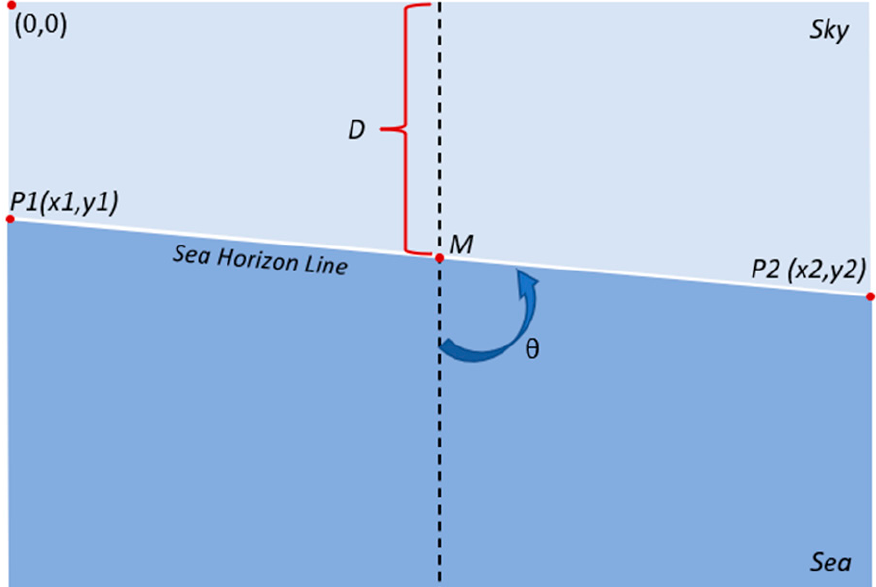
Figure 4. Ground truth marking scheme.